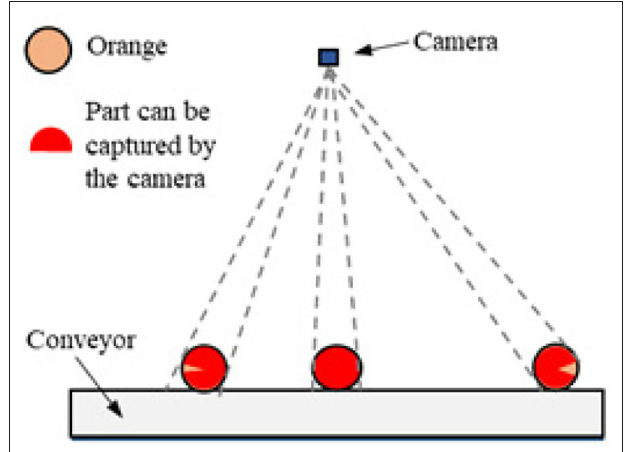
FIGURE 3 | Diagram illustrating the part of the fruit surface captured by the camera in the rotation process.